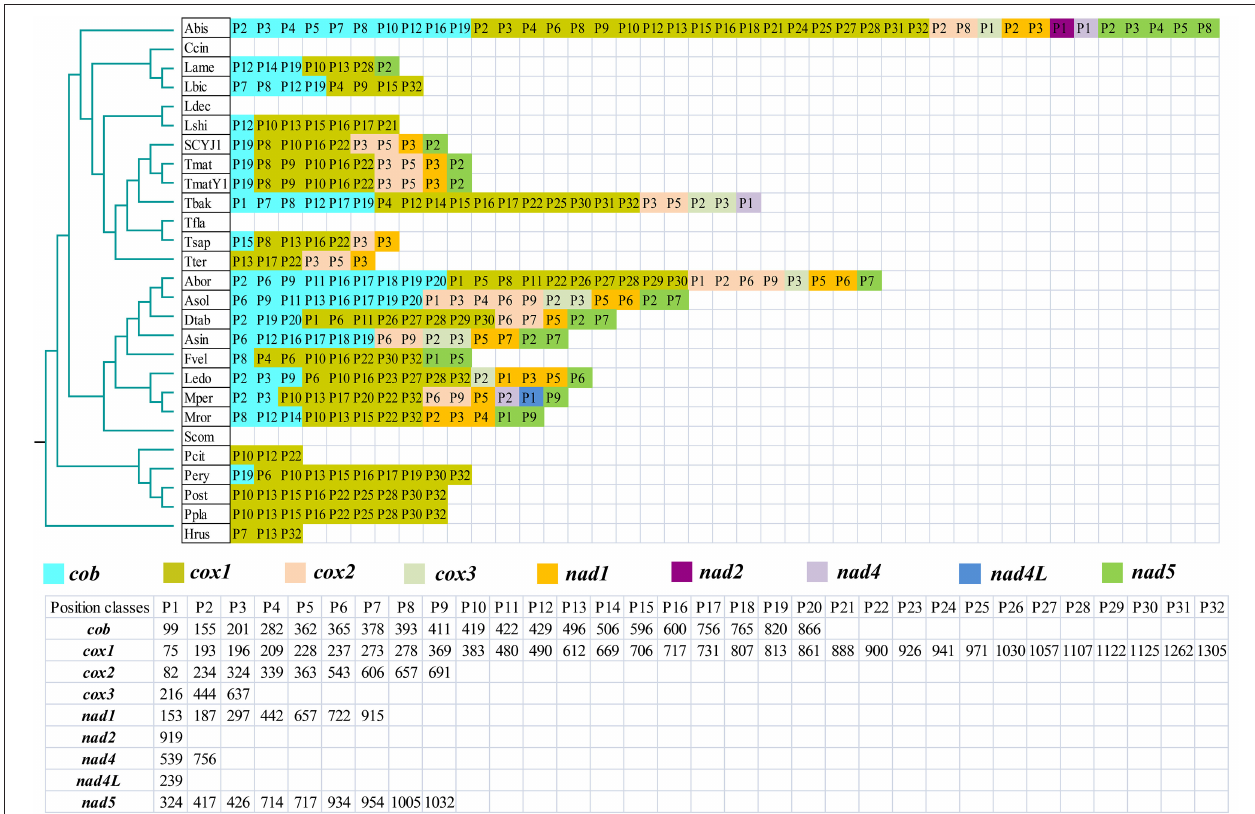
FIGURE 6 | Position class ( Pcl) information of core protein coding genes (PCGs) of the 27 Agaricales species. The phylogenetic positions of 27 Agaricales species were established using the Bayesian inference (BI) method and maximum likelihood (ML) method based on 15 concatenated mitochondrial core proteins. Species information is provided in Supplementary Table 9